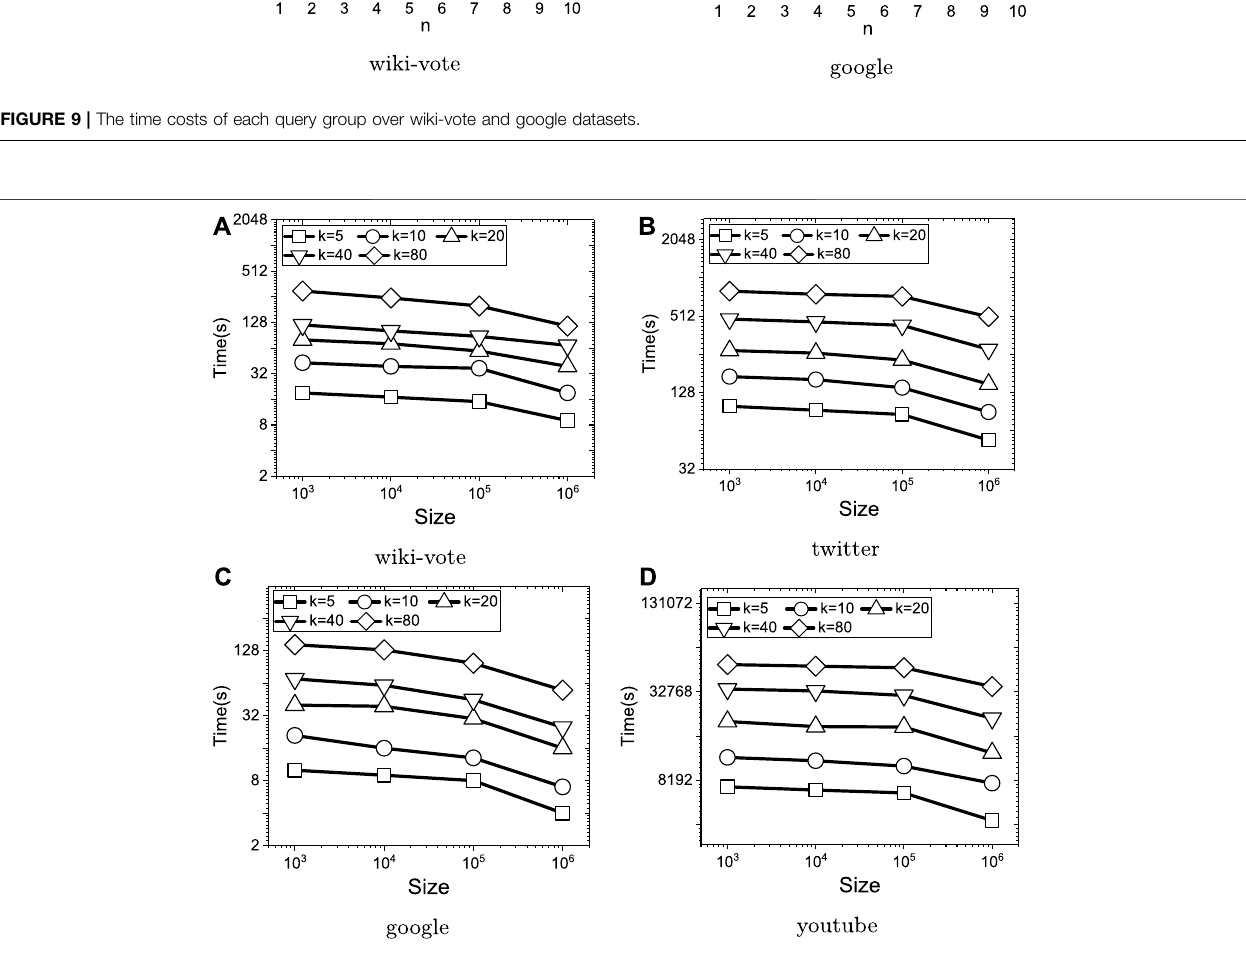
FIGURE 10 | The effects of adjusting the index